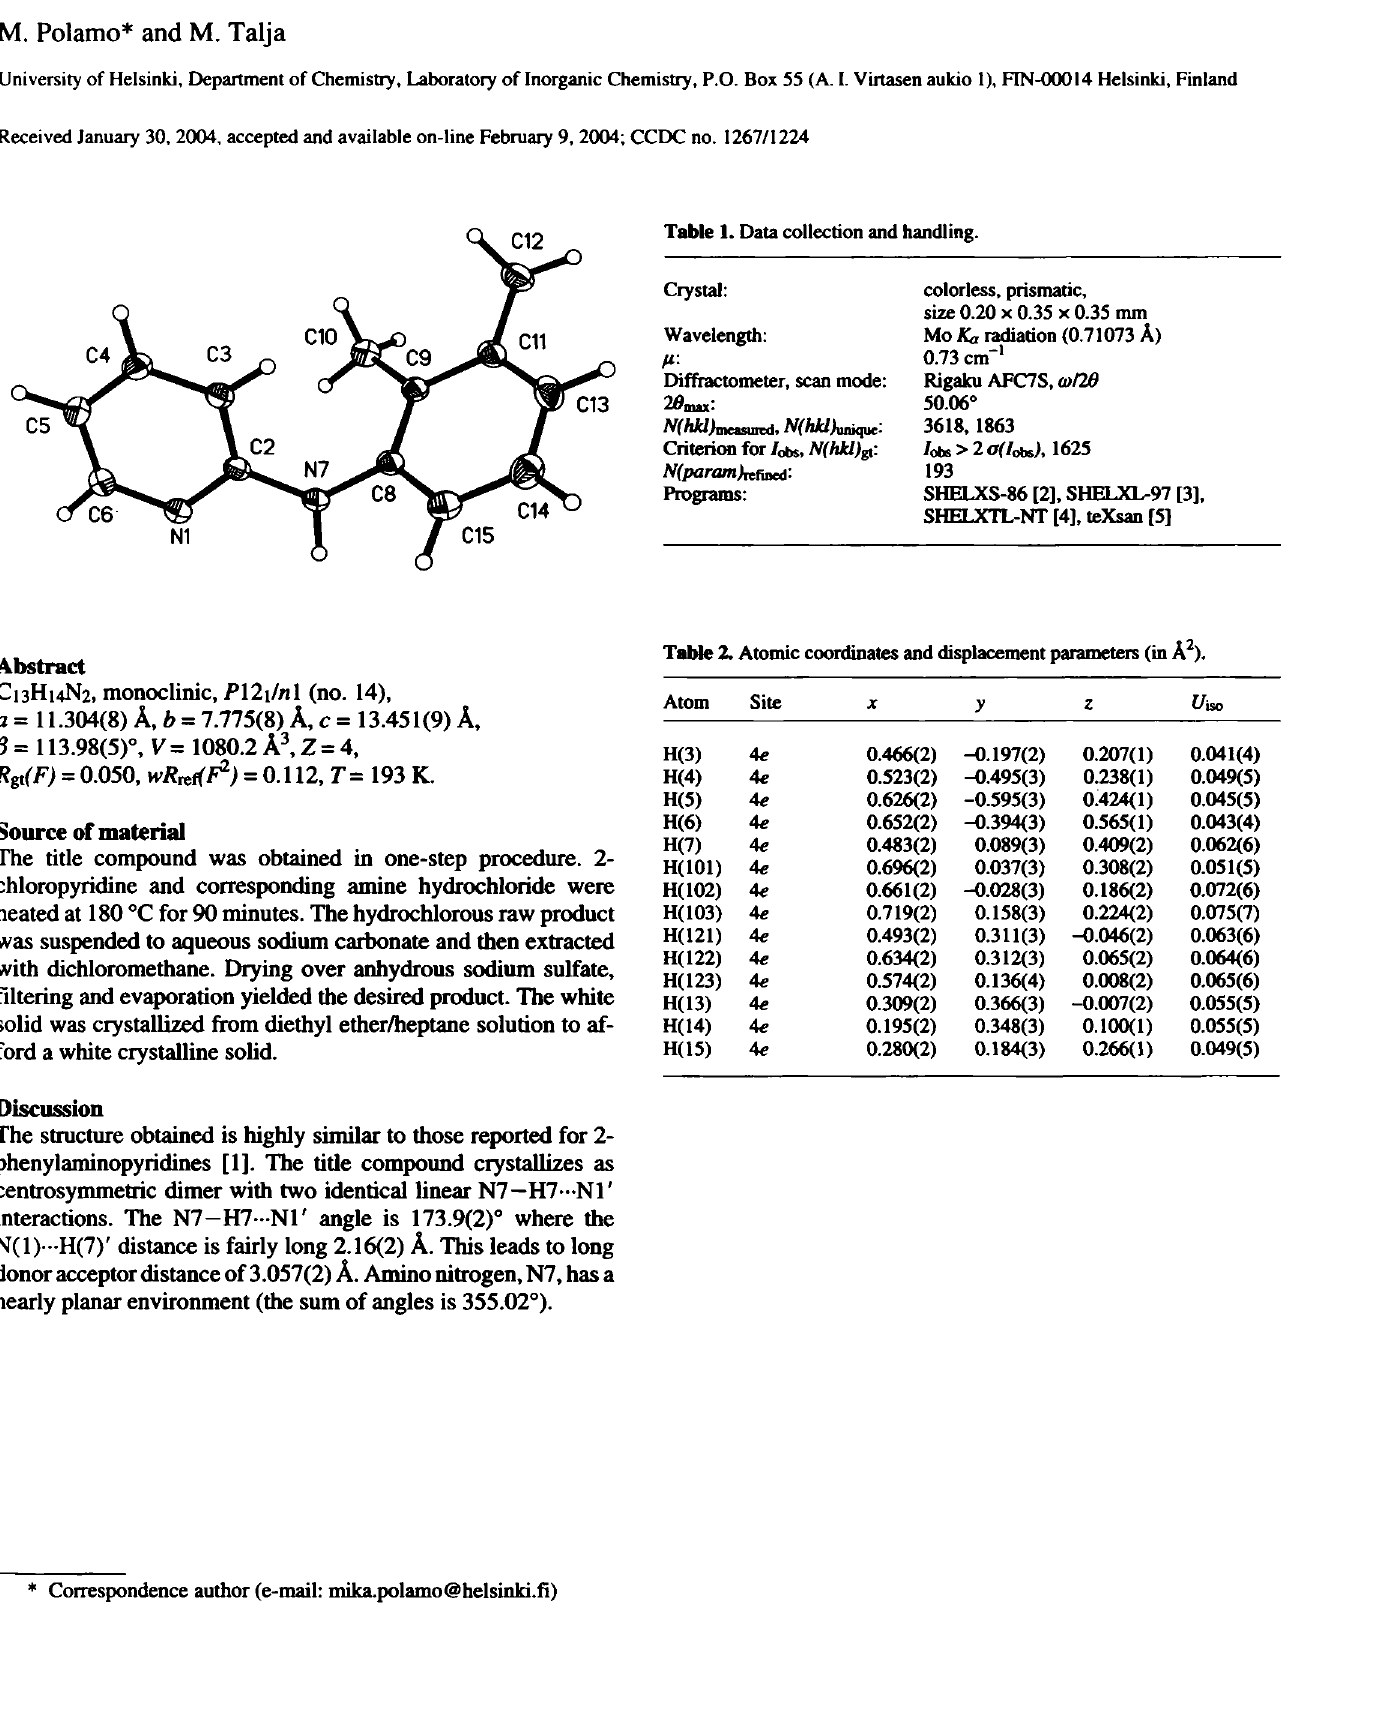
Table 2. Atomic coordinates and displacement parameters (in Â 2